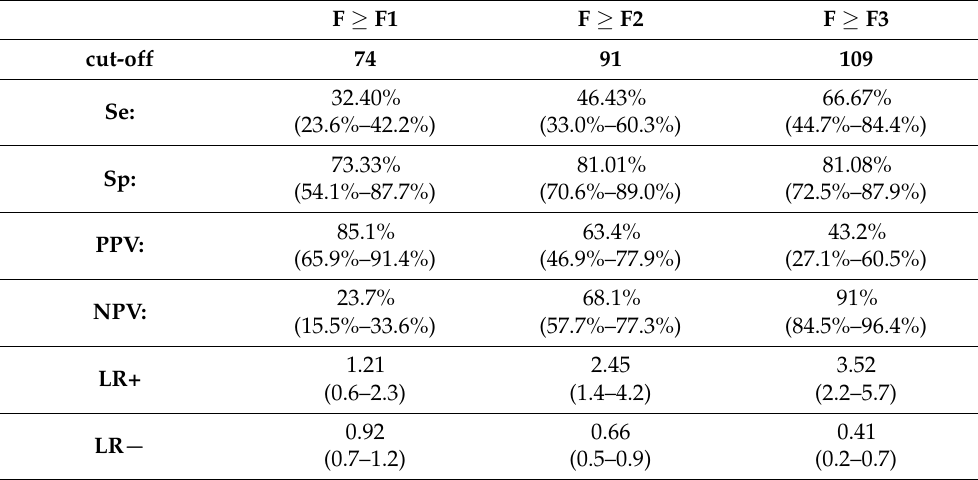
Table 4. The diagnostic performance of M30 for fibrosis grades greater than or equal to 1, greater than or equal to 2, and greater than or equal to